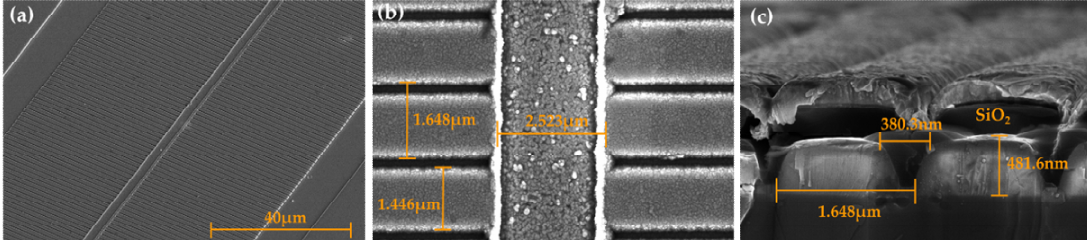
Figure 4. Scanning electron microscope (SEM) images of ( a ) an oblique view of the fabricated DFB laser diodes with surface gratings, ( b ) a top vision of the 20th order surface gratings alongside a metal stripe, and ( c ) a sectional structure of the surface gratings perpendicular to the facet of LDs.